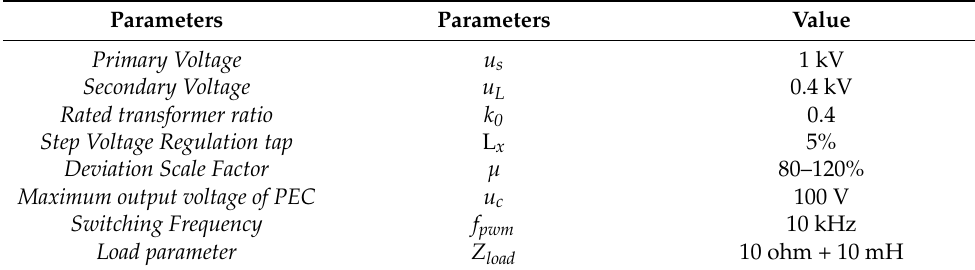
Figure 16. Experimental platform of flexible OLVR transformer. Table 2. Major parameters of experiment circuit.